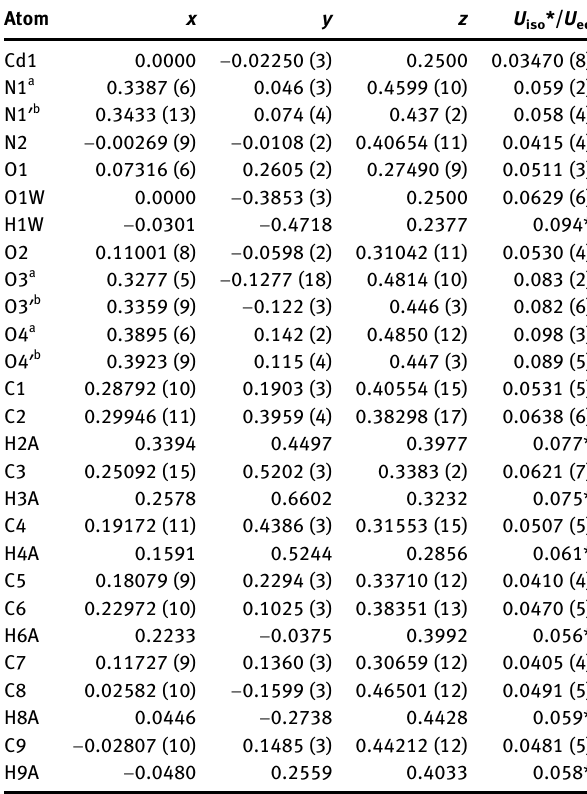
Table  : Fractional atomic coordinates and isotropic or equivalent isotropic displacement parameters (Å 